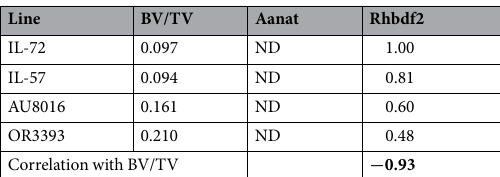
Line BV/TV Rhbdf2